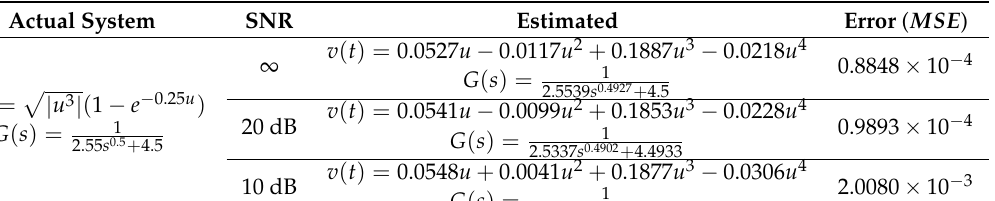
Table 1. Identification results for Example 1.